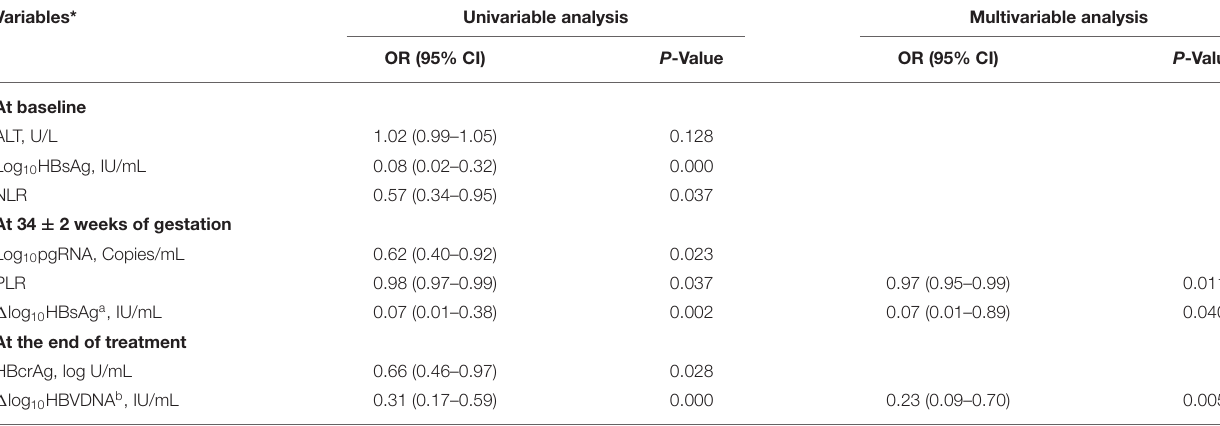
TABLE 2 | Factors predictive of post-partum HBV DNA non-rebound for 92 patients with MTCT prevention. Variables* Univariable analysis